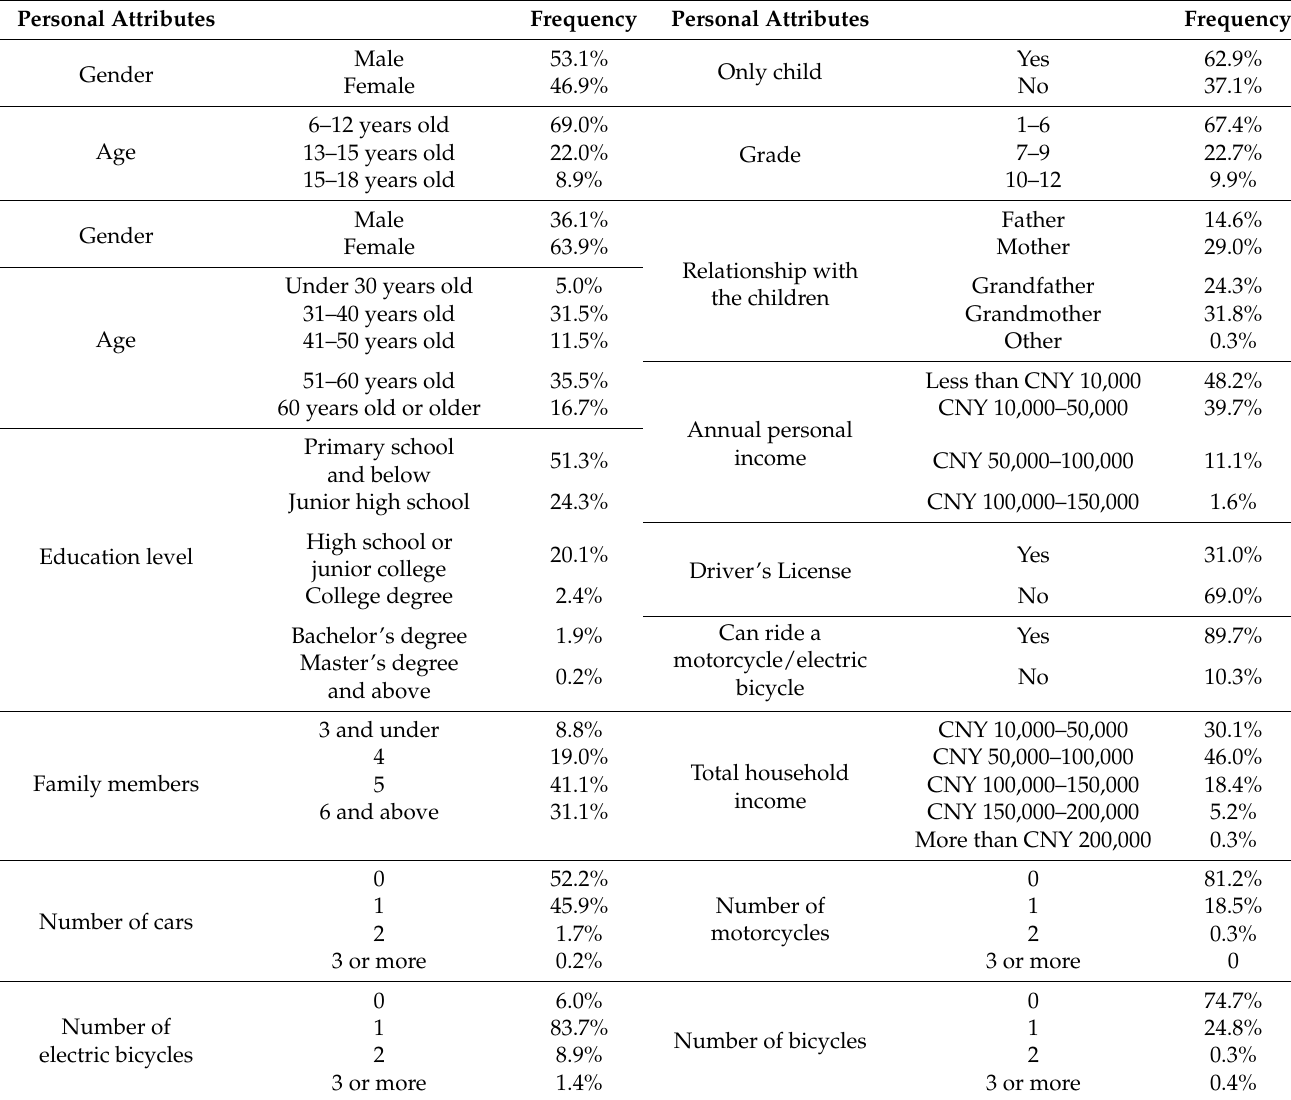
Table 1. Sociodemographic